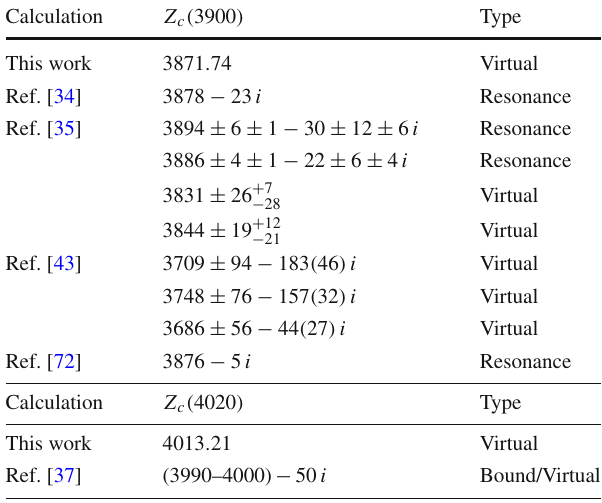
Table 3 Comparison of our S -matrix pole position, in MeV/c 2 ,